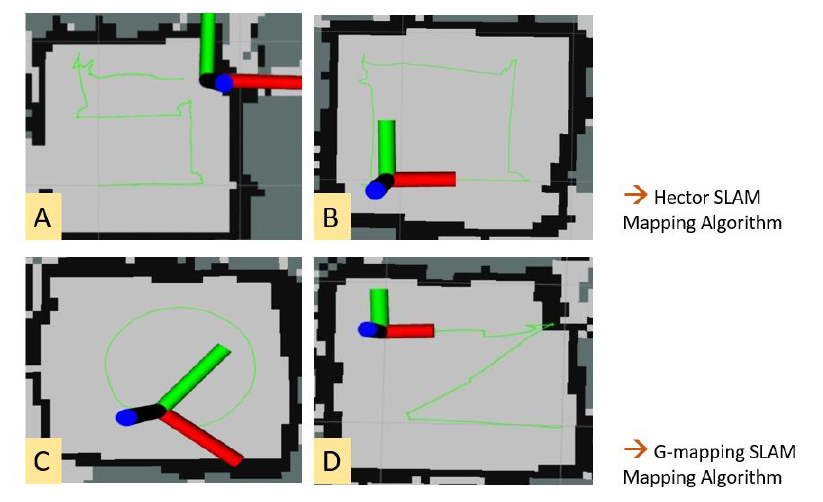
Figure 18. ( A ) S-Shaped; ( B ) Square; ( C ) Circle; ( D )